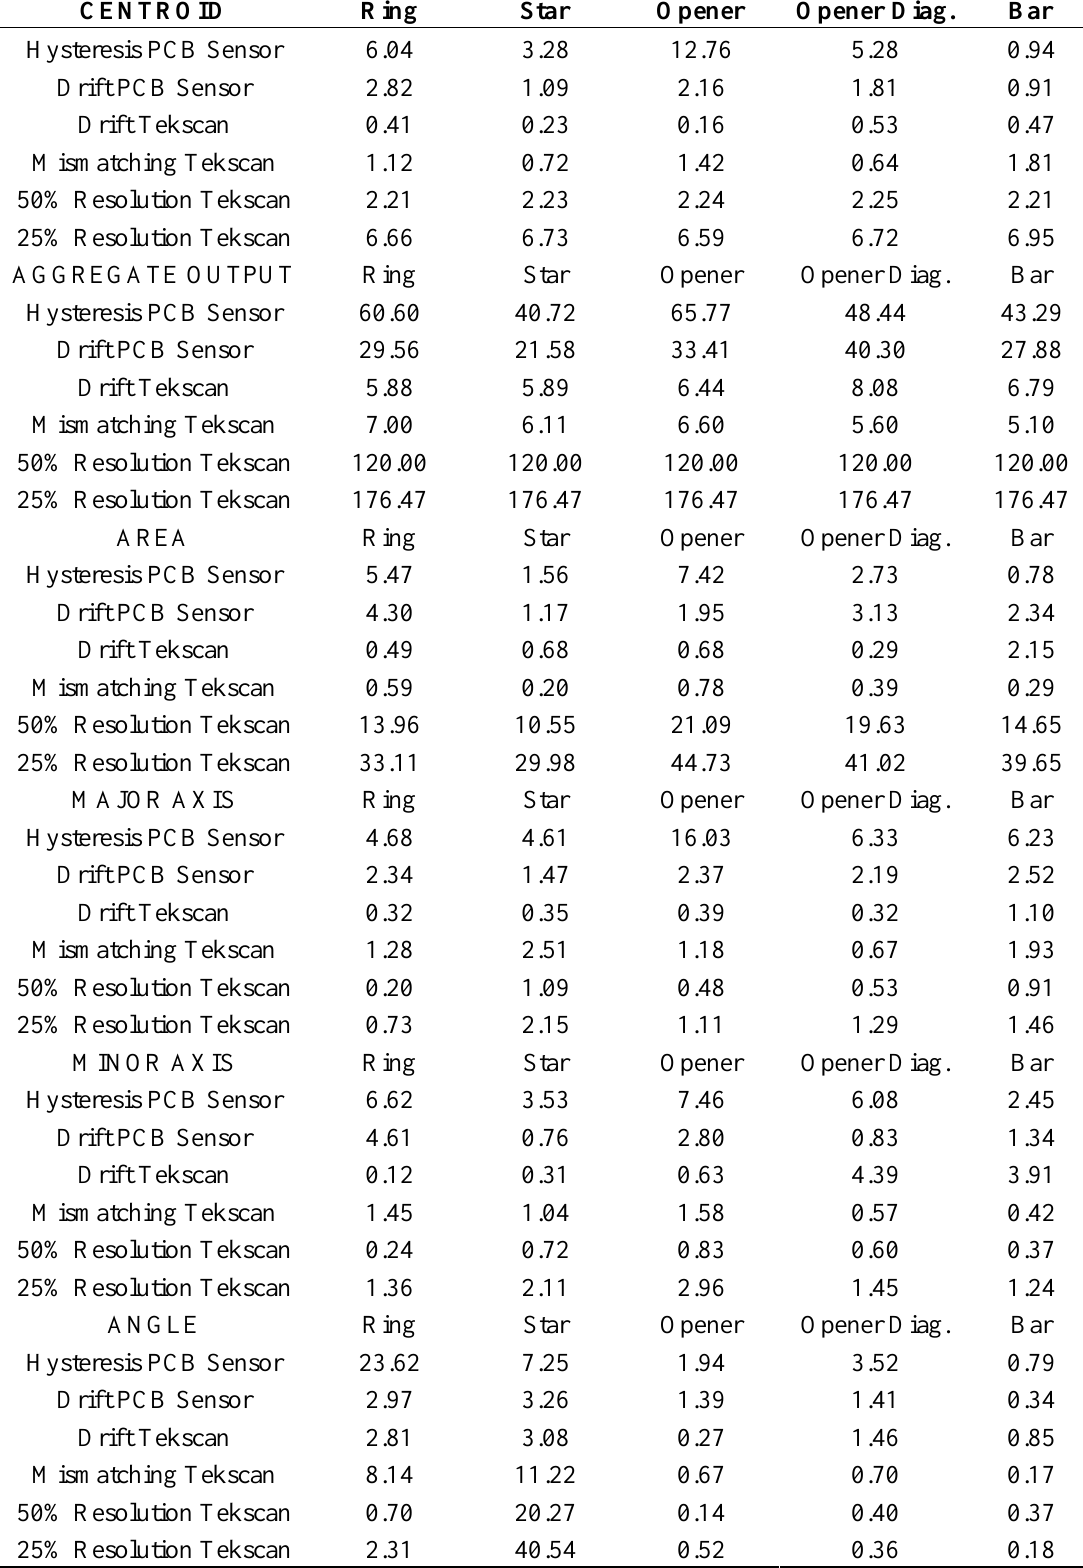
Table 11. Comparison of the influence of different non idealities on the parameters of Table 4 (maximum